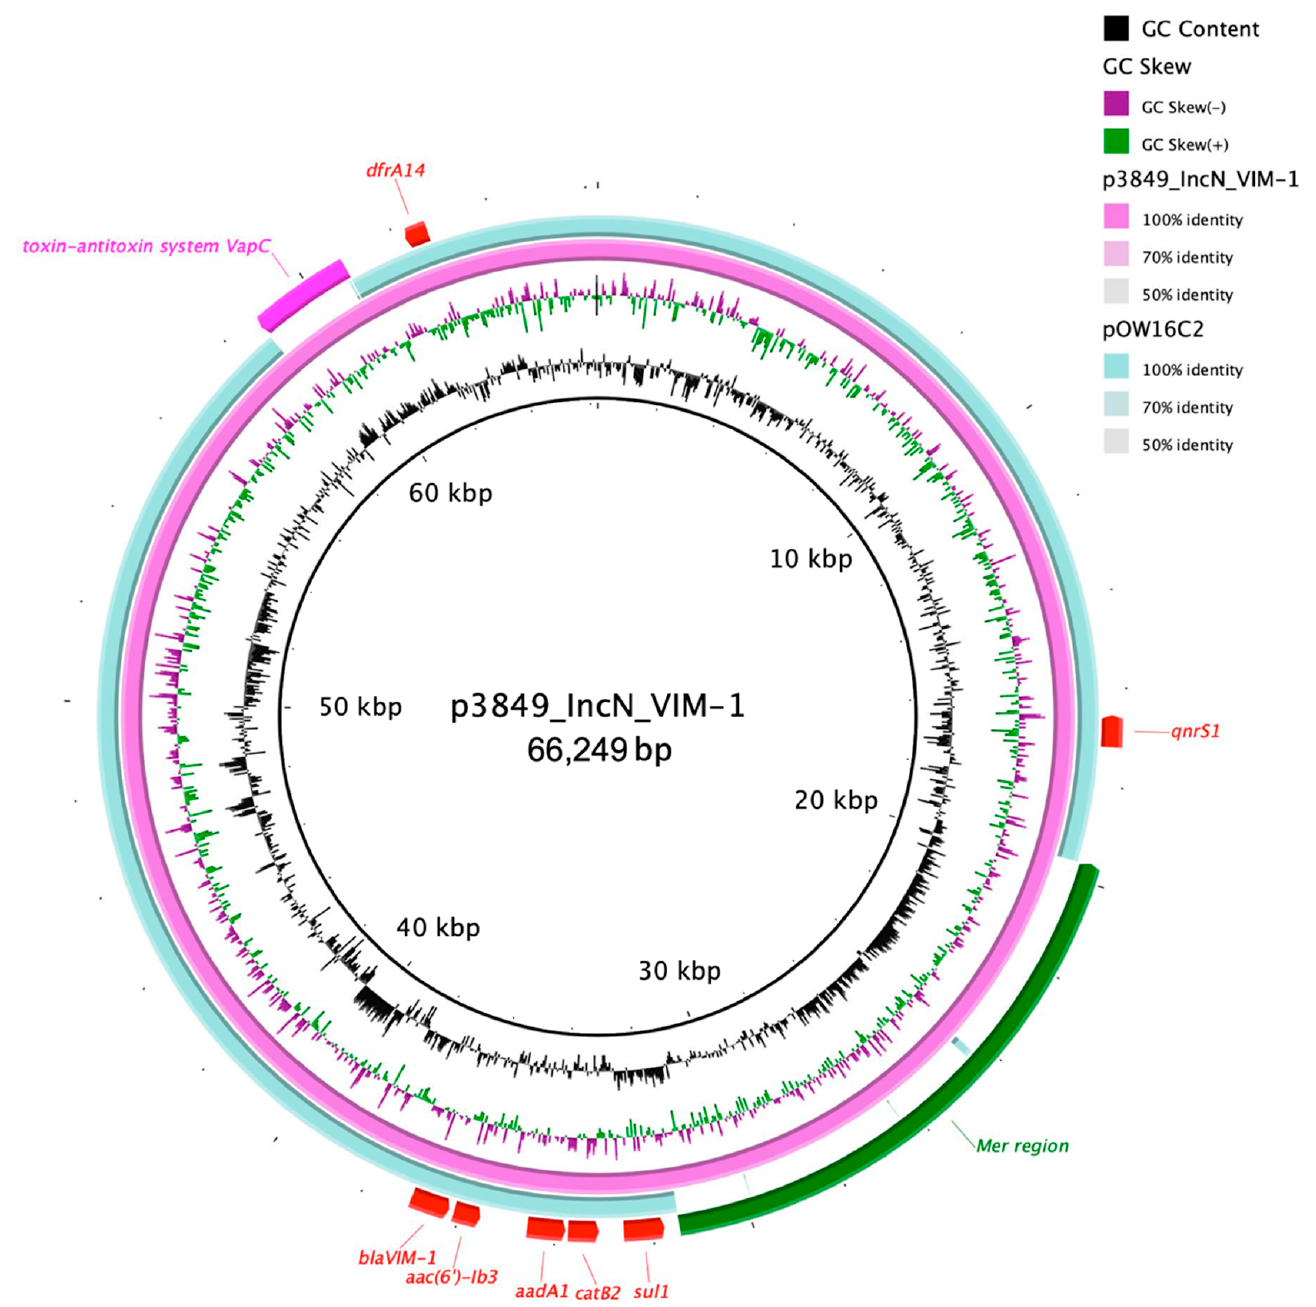
Figure 1. The circular map of p3849_IncN_VIM-1 (pink) against pOW16C2 (turquoise). The outer most curved segments (green, red and purple) correspond to antibiotic resistance genes, the mer region, and the toxin-antitoxin system.